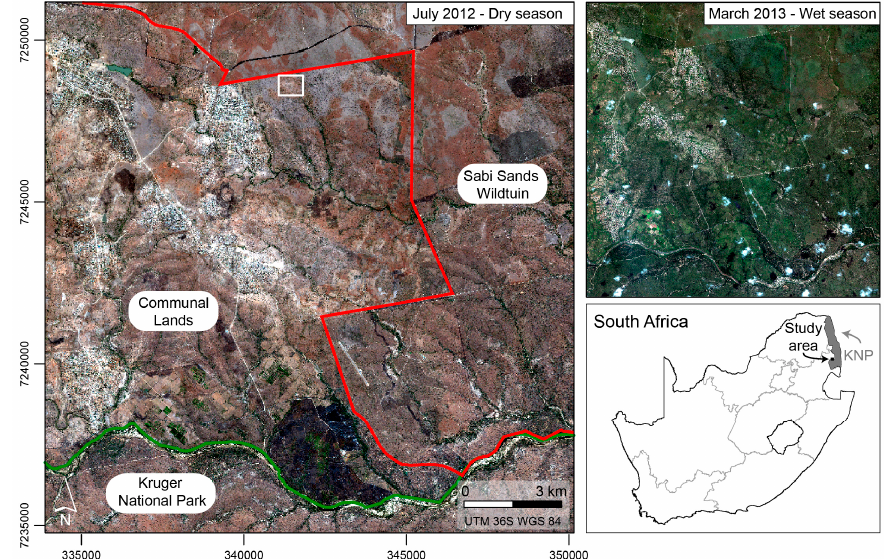
Figure 1. Overview of the study area. True color composites (derived from the WorldView-2 image) for both the dry season and wet season are illustrated. The borders of Kruger National Park and Sabi Sands Wildtuin are marked in green and red, respectively. The white rectangle corresponds to the subset used in Figure 2.